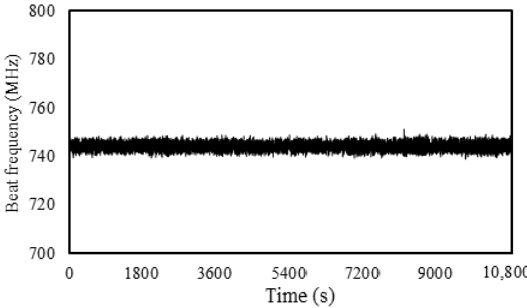
Figure 5. Frequency stability of the locked LD for 3 h.